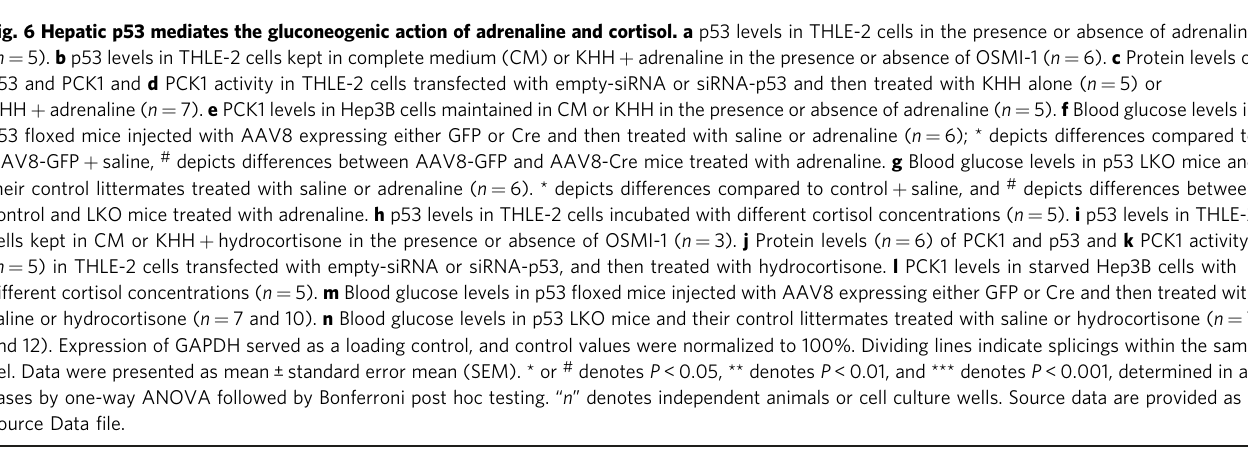
Fig. 6 Hepatic p53 mediates the gluconeogenic action of adrenaline and cortisol. a p53 levels in THLE-2 cells in the presence or absence of adrenaline ( n = 5). b p53 levels in THLE-2 cells kept in complete medium (CM) or KHH + adrenaline in the presence or absence of OSMI-1 ( n = 6). c Protein levels of p53 and PCK1 and d PCK1 activity in THLE-2 cells transfected with empty-siRNA or siRNA-p53 and then treated with KHH alone ( n = 5) or KHH + adrenaline ( n = 7). e PCK1 levels in Hep3B cells maintained in CM or KHH in the presence or absence of adrenaline ( n = 5). f Blood glucose levels in p53 fl oxed mice injected with AAV8 expressing either GFP or Cre and then treated with saline or adrenaline ( n = 6); * depicts differences compared